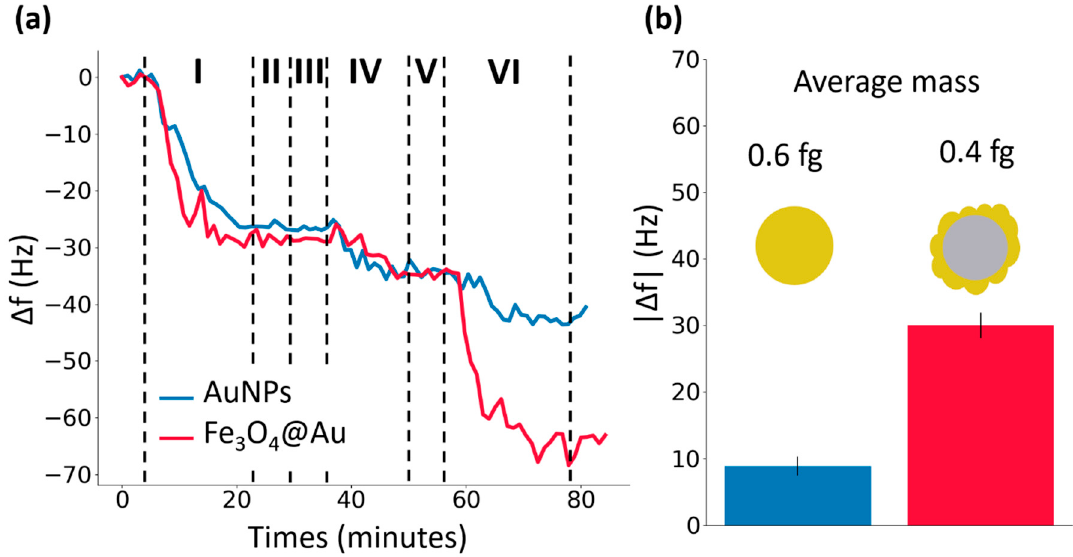
Figure 5. Comparison between the amplification effects due to AuNPs and core-shell magnetic NPs. ( a ) The blue and the red lines represent the response of the sensing ribbon to the following steps: (I) functionalization with 25 μ g ∙ mL − 1 of UV-activated antibodies (anti-human IgG) which causes a shift of the resonance frequency Δ f ≃ 30 Hz; (II) rinse with MilliQ water; (III) flowing of bovine serum albumin solution (50 μ g ∙ mL − 1 ); (IV) exposure to the antigen solution (human IgG) which causes a shift Δ f ≃ 10 Hz; (V) rinse with MilliQ water; (VI) amplification with AuNPs for the blue line and amplification with core-shell magnetic NPs for the red line. The former causes a shift Δ f = 9 ± 1 Hz while the latter causes a shift Δ f = 30 ± 2 Hz. ( b ) A direct comparison between the amplification of the response signal due to AuNPs (blue) and core-shell magnetic NPs (red).